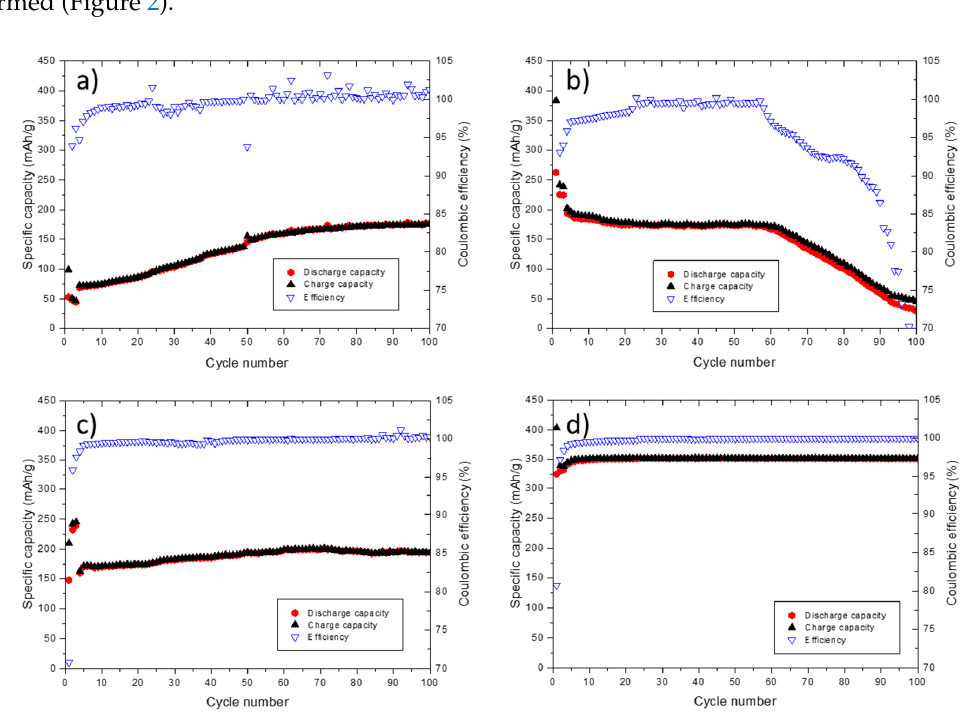
Figure 2. Cycling profiles of graphite/Li cells containing 1 M LiPF 6 in EMS with ( a ) 1% FEC; ( b ) 2% FEC; ( c ) 3% FEC and ( d ) 4% FEC, in the potential range from 0.02 to 1.5 V vs. Li/Li + .